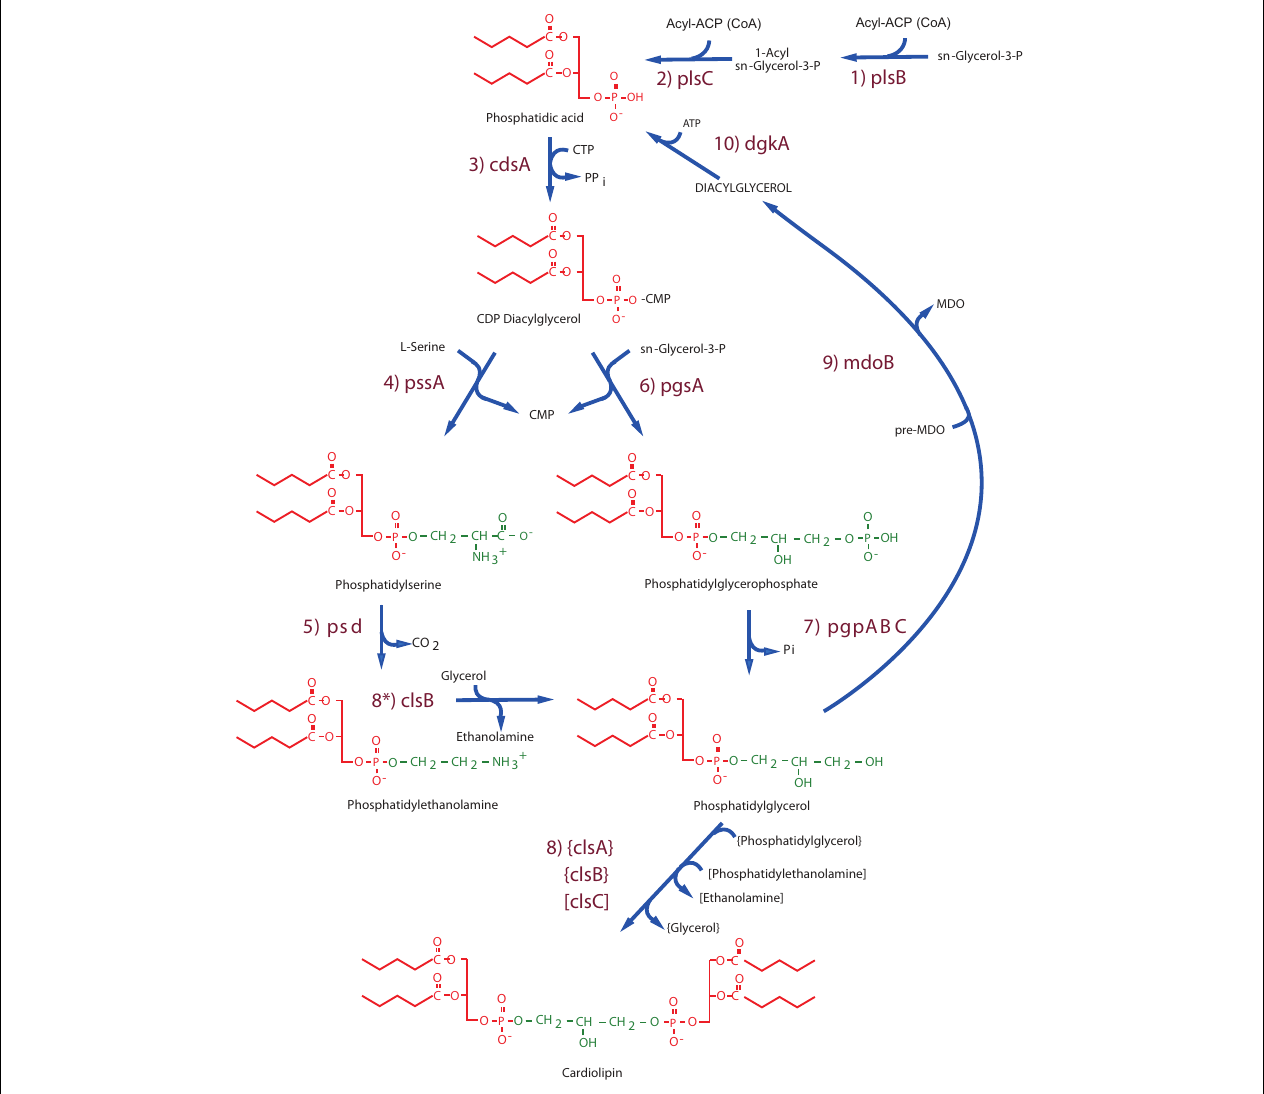
FIGURE 1 | Kennedy Pathway for synthesis of phospholipids in Escherichia coli . The following enzymes with their respective genes named carry out: (1) G3P acyltransferase (PlsB); (2) 1-Acyl-G3P acyltransferase (PlsC); (3) CDP-DAG synthase (CdsA); (4) phosphatidylserine synthase (PssA); (5) phosphatidylserine decarboxylase (Psd); (6) phosphatidylglycerophosphate synthase (PgsA); (7) phosphatidylglycerophosphate phosphatases (PgpABC) encoded by three genes; (8) cardiolipin synthase (Cls) encoded by three genes. ClsA and ClsB condense 2 PGs while ClsC condenses PG and PE. ClsB (8*) can also displace ethanolamine from PE using glycerol to make PG, which can be utilized to make CL in pgsA null strains. (9) PG pre-membrane derived oligosaccharide (MDO) sn -glycerol-1- P transferase (MDO synthase); 10. DAG kinase (DgkA). Figure (modified) and legend reprinted by permission from Elsevier (Dowhan, 2013): Copyright 2013.